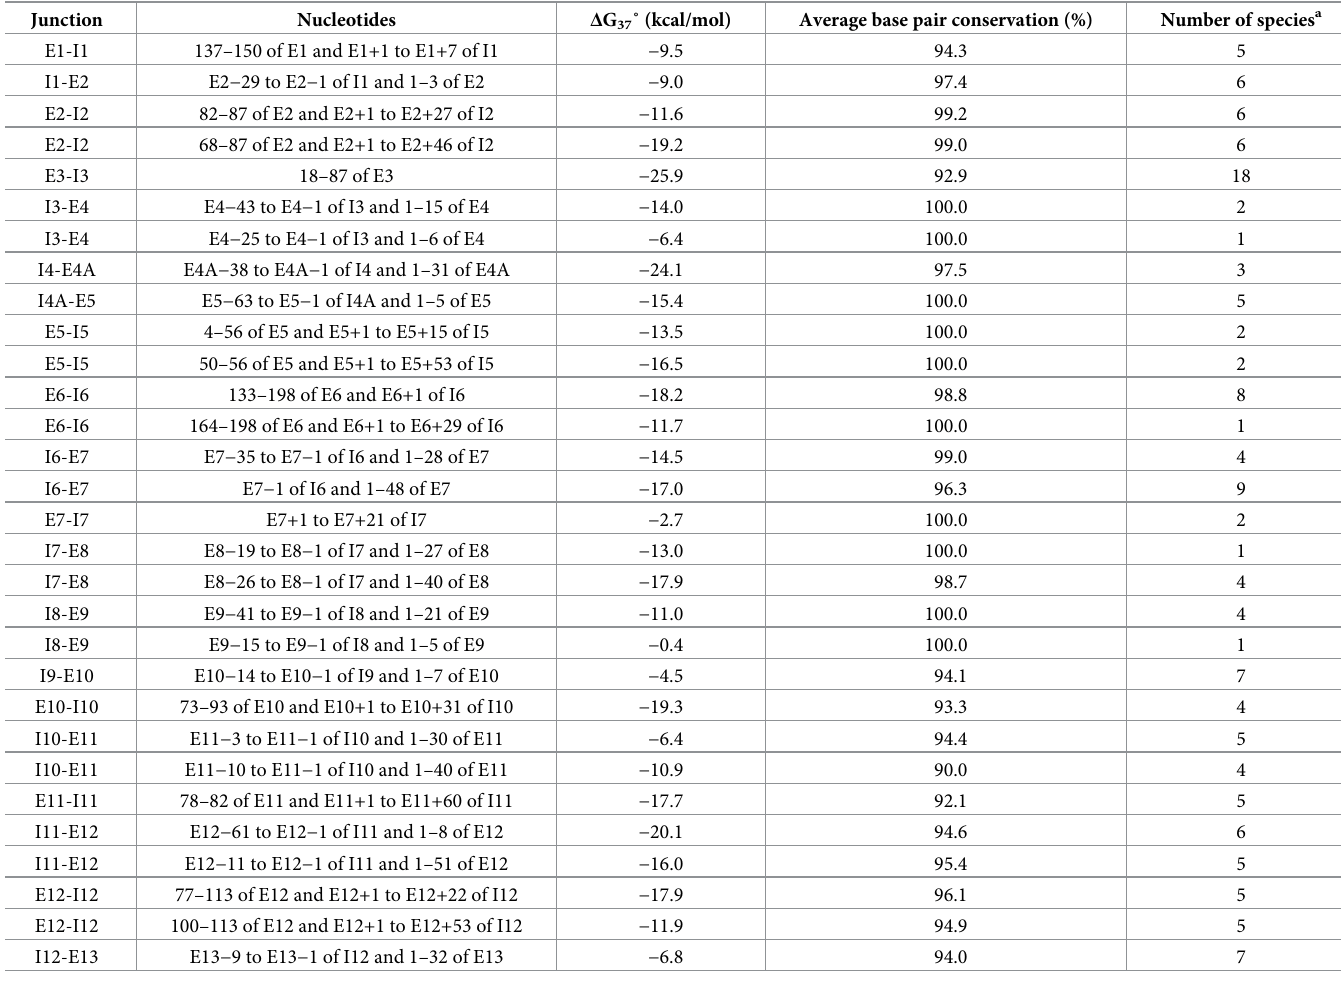
Table 1. Exon-intron junctions containing predicted wild type